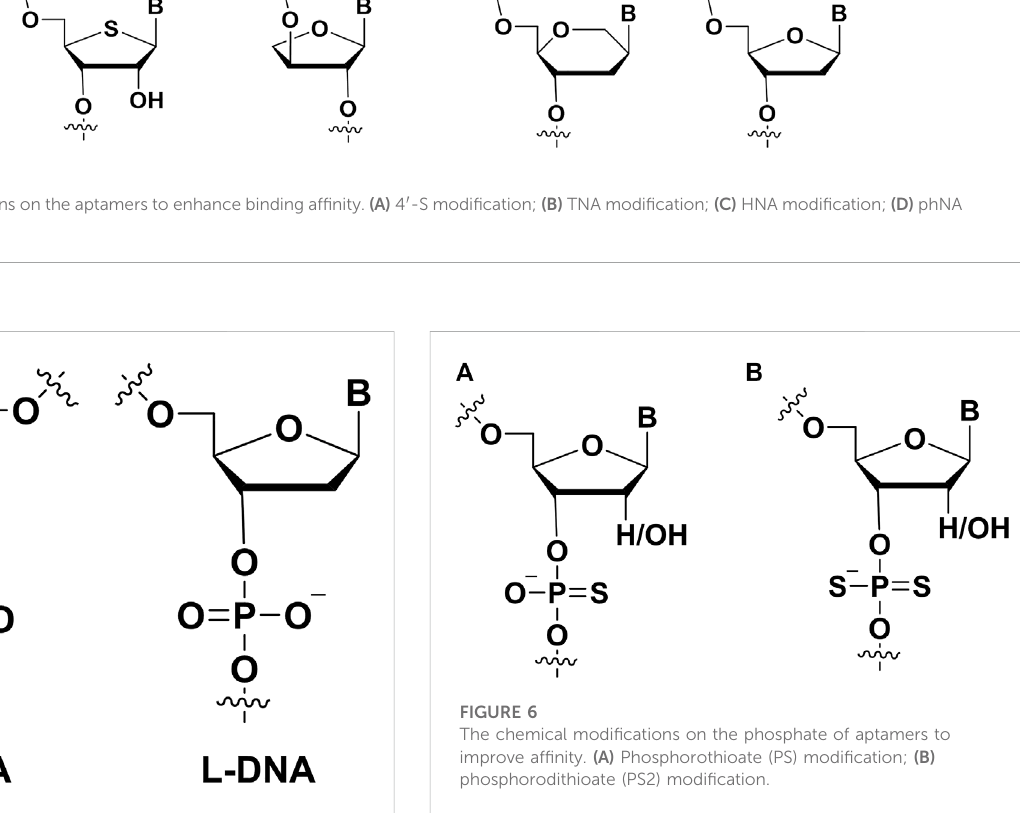
FIGURE 5 Themirror-imagenucleotide(L-DNA)modi fi cationonaptamers.